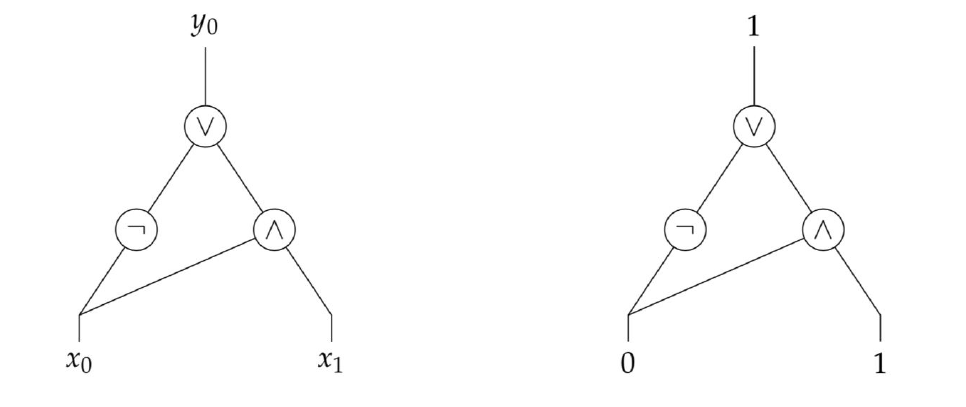
representing strategy f 14 v v 3